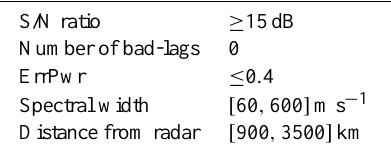
Table 1. Selection criteria for the our database of ACFs.